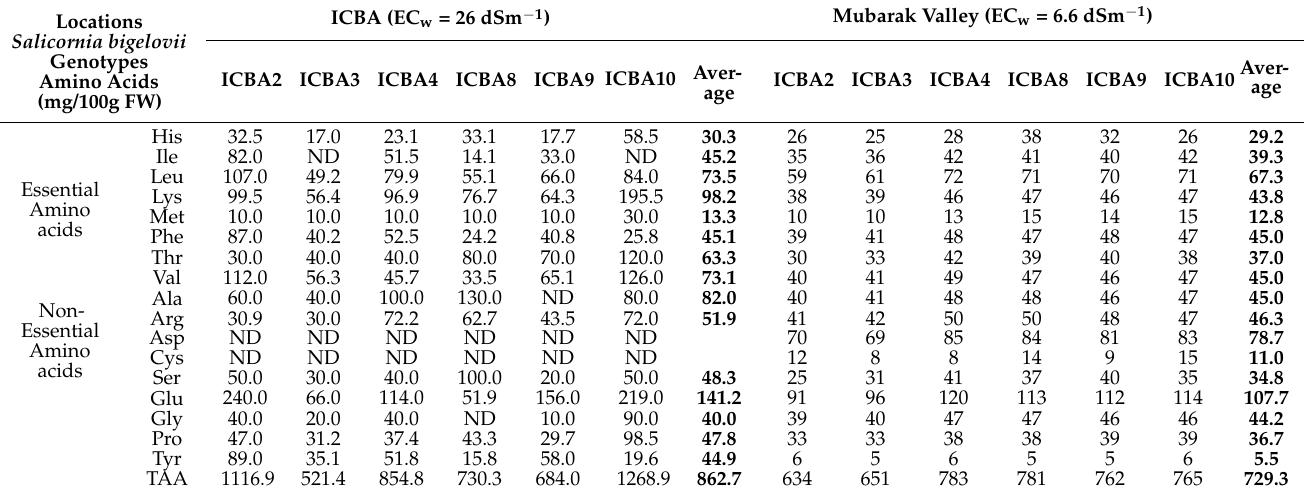
Table A2. Essential and non-essential amino acids (mg/100g) analyzed for shoots of six Salicornia bigelovii genotypes collected at three and a half months after sowing at ICBA’s experimental station and Mubarak Valley. The values are calculated on fresh weight (FW) basis. The average value per parameter from all genotypes was calculated (in bold) for each location.